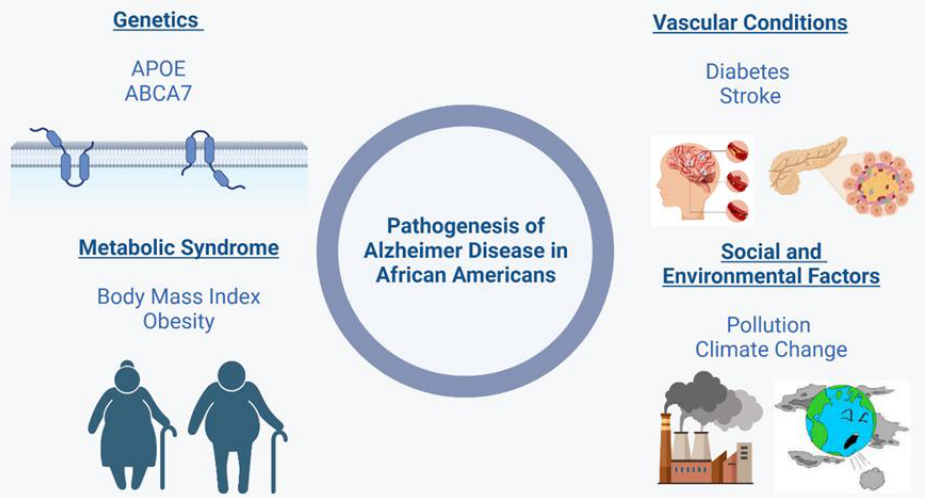
Figure 2. Pathogenic mechanisms of Alzheimer’s Disease in African Americans including genetic factors, vascular conditions, metabolic syndromes, and social and environmental